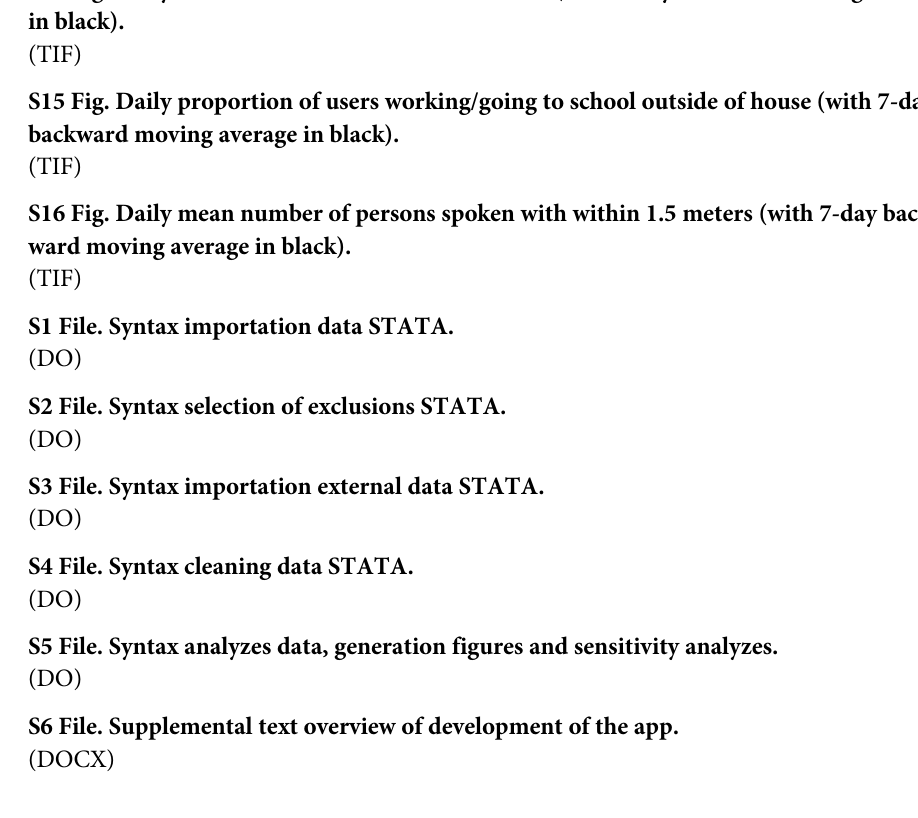
S7 Fig. Mean difference between values of users reporting behavior and daily means per day surrounding positive SARS-CoV-2 test (red line: No difference with daily mean) with 95% confidence intervals. (TIF) S8 Fig. Proportion of users asymptomatic per day surrounding positive SARS-CoV-2 test. S9 Fig. Mean difference between number of symptoms reported by users reporting symp- toms and daily mean number per day surrounding positive SARS-CoV-2 test (red line: No difference with daily proportion) with 95% confidence intervals. S10 Fig. As S6 Fig, but than for negative SARS-CoV-2 test. S11 Fig. As. S7 Fig, but than for negative SARS-CoV-2 test. S12 Fig. As S8 Fig, but than for negative SARS-CoV-2 test. S13 Fig. As S9 Fig, but than for negative SARS-CoV-2 test. S14 Fig. Daily mean number of hours out of house (with 7-day backward moving average in black). S15 Fig. Daily proportion of users working/going to school outside of house (with 7-day backward moving average in black). S16 Fig. Daily mean number of persons spoken with within 1.5 meters (with 7-day back- ward moving average in